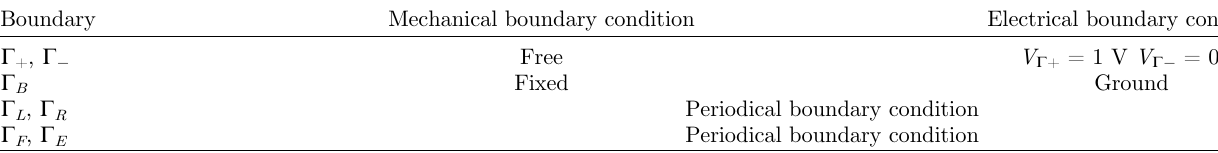
Table 1. Boundary conditions of the FEM analysis.